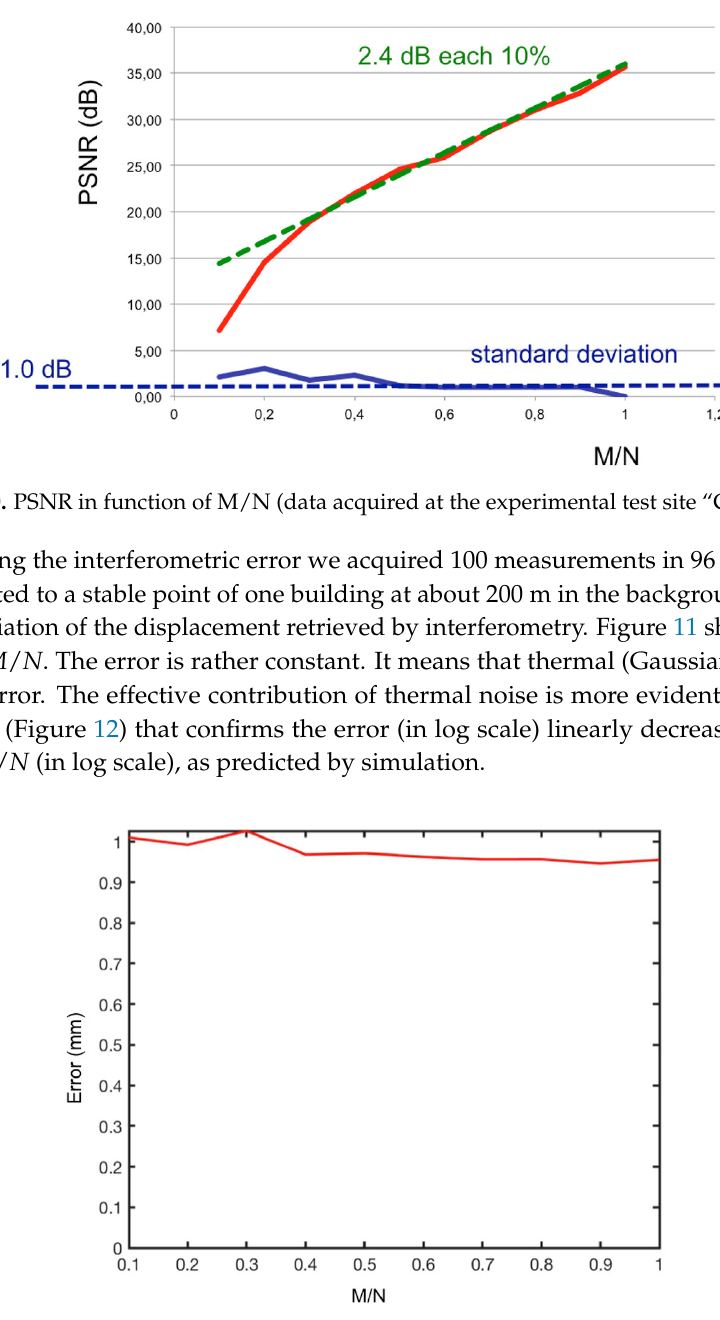
Figure 12. Differential displacement error in function of M/N for a stable point in the test site “Campus”. The metallic target in the middle of the grass was provided with a micrometric positioner able to translate it with a nominal accuracy of 0.1 mm. So, we performed 20 radar acquisitions by moving the target of 1 mm forward the radar after each acquisition. Figure 13 shows the cumulative displacement detected by interferometry using 100% of data without CS, using 100% of data with CS, using 50% of data with CS, and using 30% of data with CS. The four plots are practically overlapping. Figure 14 shows the plots of the differences. In the worst case (CS with 30% of data) the error is lower than 25 μm.